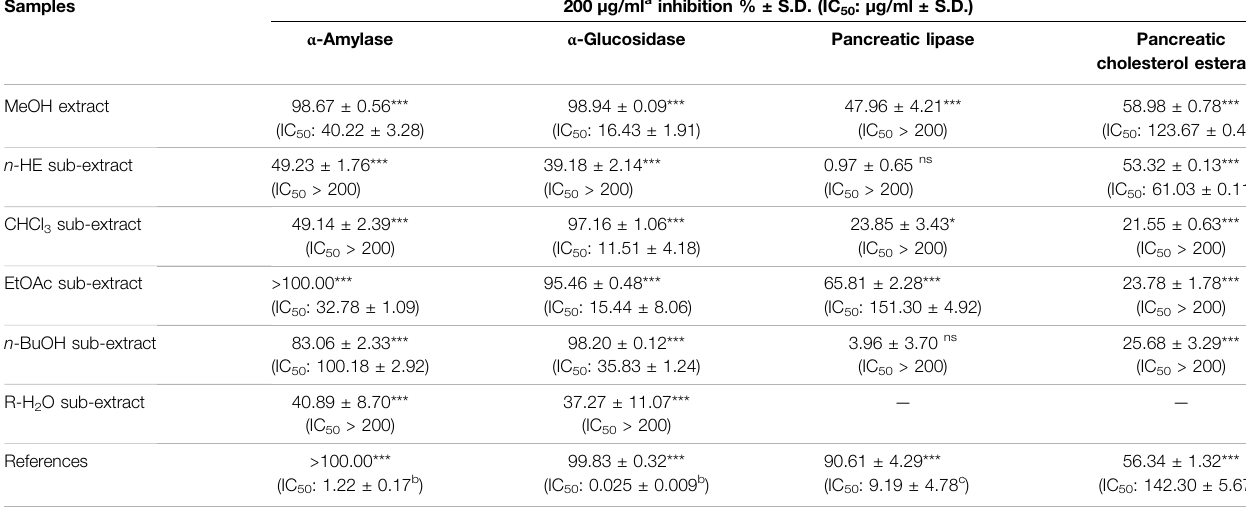
TABLE 2 | Enzyme inhibitory activity results of P. atlantica MeOH and sub-extracts.